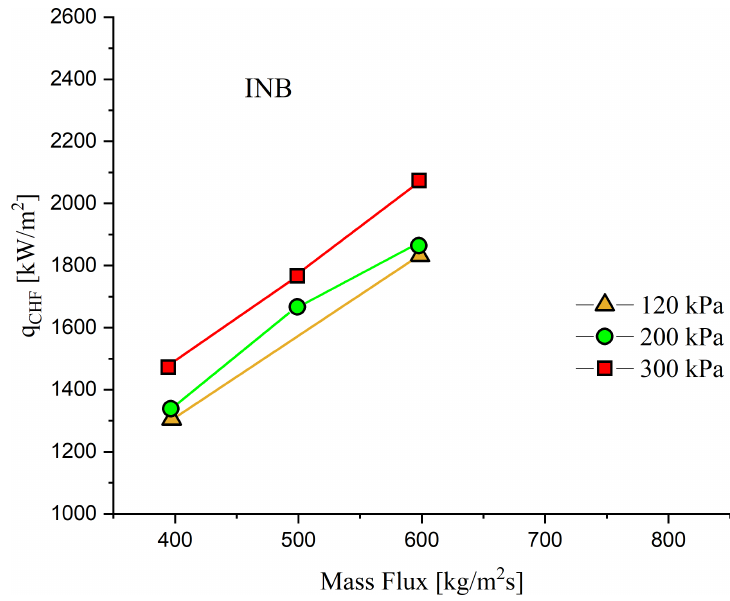
Figure 14. CHF measurements as a function of mass flux at different outlet pressures and inlet subcooling on Inconel bead blasted